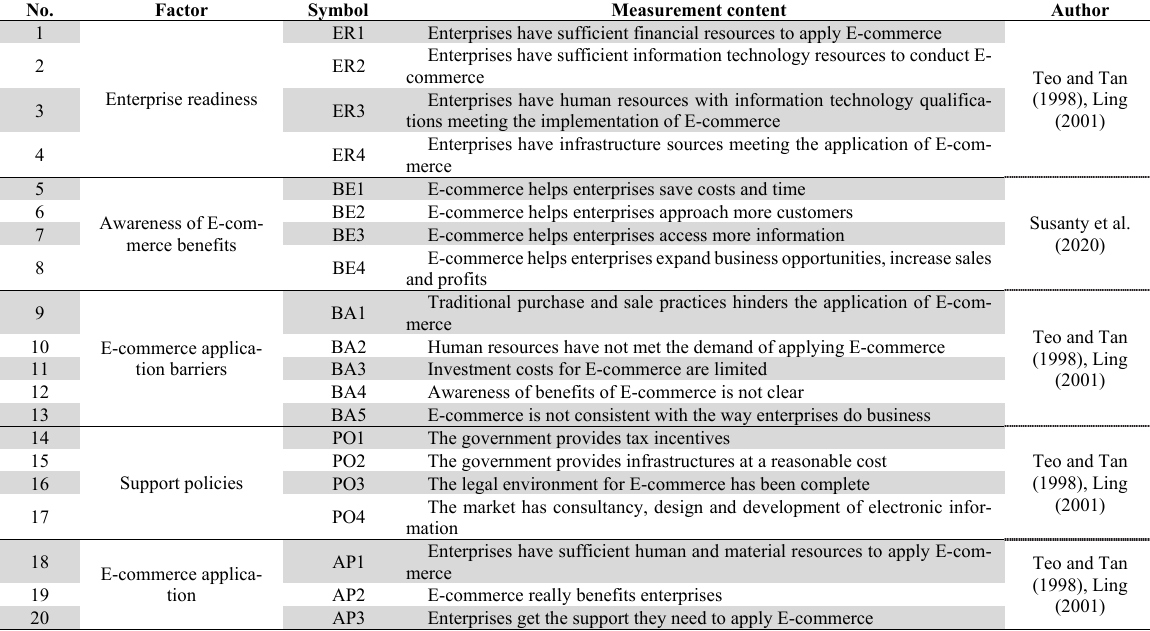
Measurement scales for the